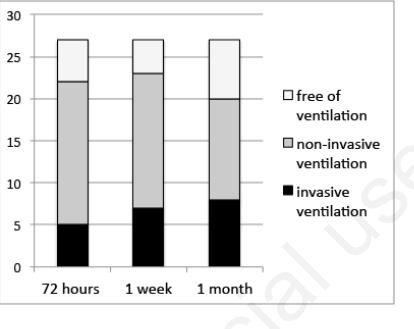
Figure 1. The number of patients with neu- romuscular diseases who had acute respira- tory failure and received continuous non- invasive mechanical ventilation (NIV) sup- port, number of patients who required invasive ventilation, and that of patients who could discontinue NIV.